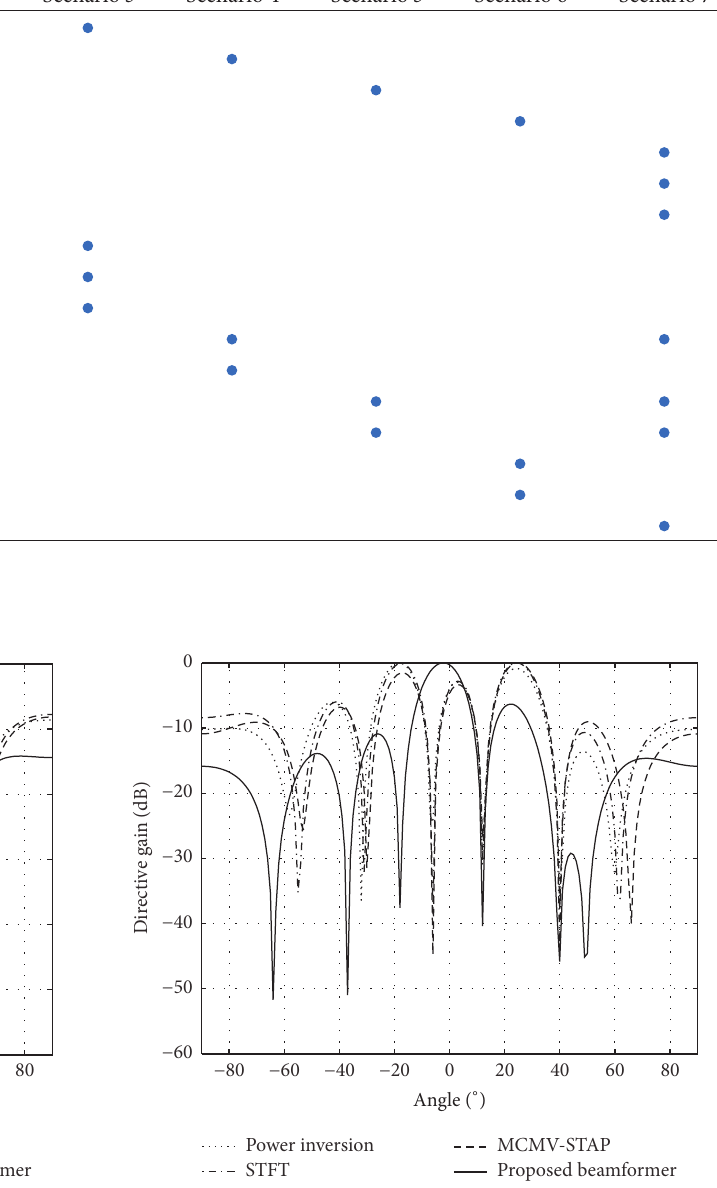
Figure 6: The array antenna pattern of antijamming for different method: the angle of arrival of the satellite signal is 0 degrees and the angles of arrival of jamming signals are − 6 degrees and 12 degrees.